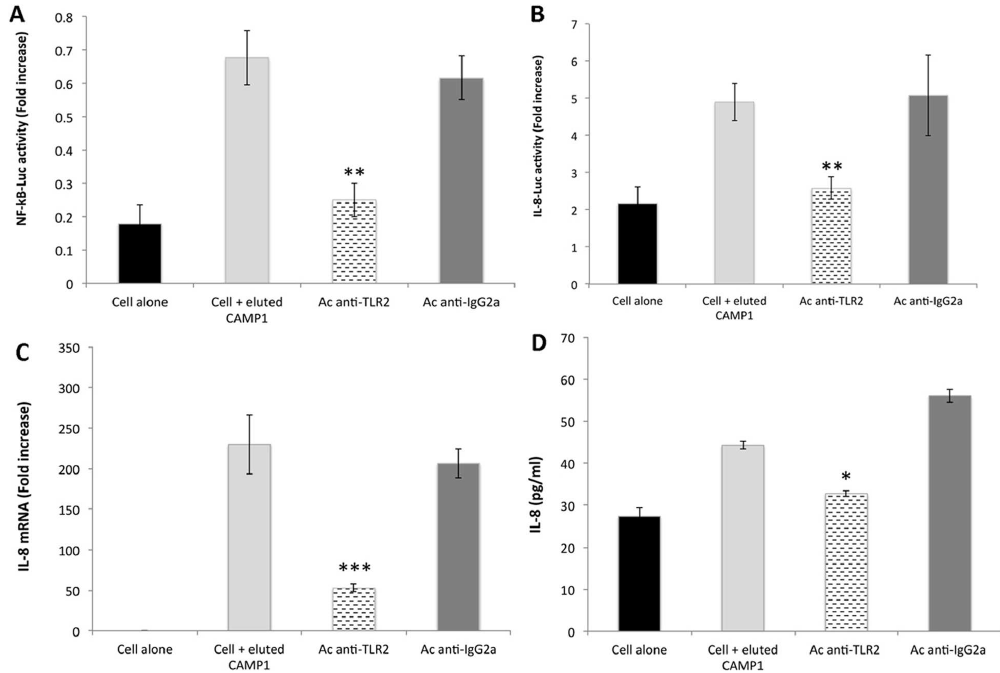
Fig 7. TLR2 blockade inhibits P . acnes CAMP factor 1-induced CXCL8 expression. Surface protein extracts were electrophoreticallyseparated in 10% SDS-PAGE gels (13 x 13 cm), with detectionby Coomassie blue staining. Proteins of interest were excised from the gel, eluted and pooledas describedin the Materialsand Methods. HaCaT cells were treated for 2 h with human anti-TLR2 (dashedbar) or with goat anti-IgGa antibodies(dark gray bar) and transfected by incubation for 24 h with NF- κ B transcriptionfactor (A) and CXCL8 (-173 bp) (B) inserted into a construct upstream from the luciferase gene, after which, an internalcontrol (the Renilla luciferaseexpression plasmid) was addedto the transfectionmixture. Cell were stimulatedwith eluted CAMP factor 1 (50 μ g/ml) for 24 h at 37˚C. RelativeNF- κ B and CXCL8 promoter activities were determinedas the ratio of firefly and Renilla luciferase activities. Pretreated HaCaT cells were stimulatedby incubation with eluted CAMP factor 1 (50 μ g/ml) for 24 h at 37˚C, CXCL8 mRNA levels were determined by RT-qPCR (C), and CXCL8 productionwas measuredby ELISA (D). Control experiments were performed with cells alone (dark bar) and with stimulated cells not previously treated with CAMP factor 1 (light gray bar). Data are presentedas the mean ± standarddeviationof two independent experiments. Statistical significanceis indicatedby * P (cid:20) 0.05, ** P (cid:20) 0.01, *** P (cid:20) 0.001, **** P (cid:20)